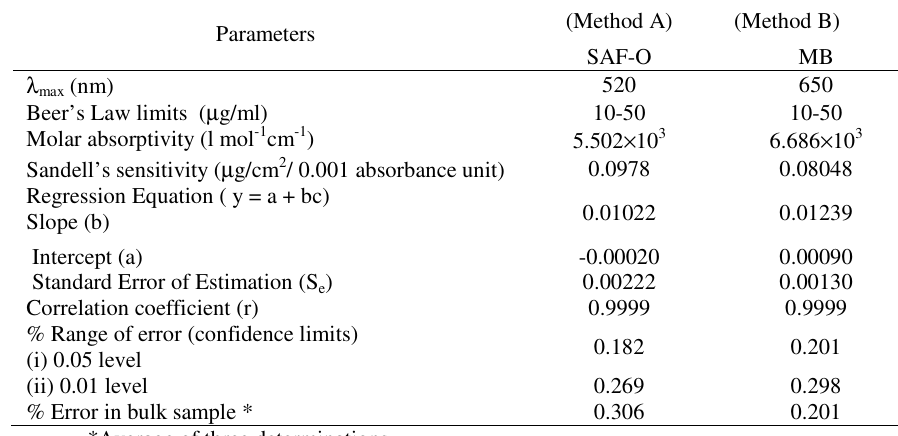
Table 1 Optical characteristics, precision and accuracy of the proposed methods for Fexofenadine